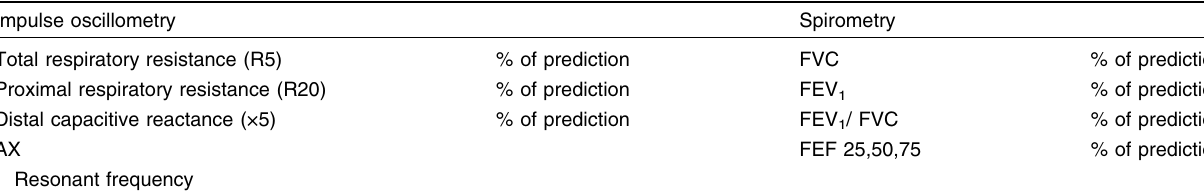
Table 1 Pulmonary function in CF patients (according to Naguib et al. [6]) Impulse